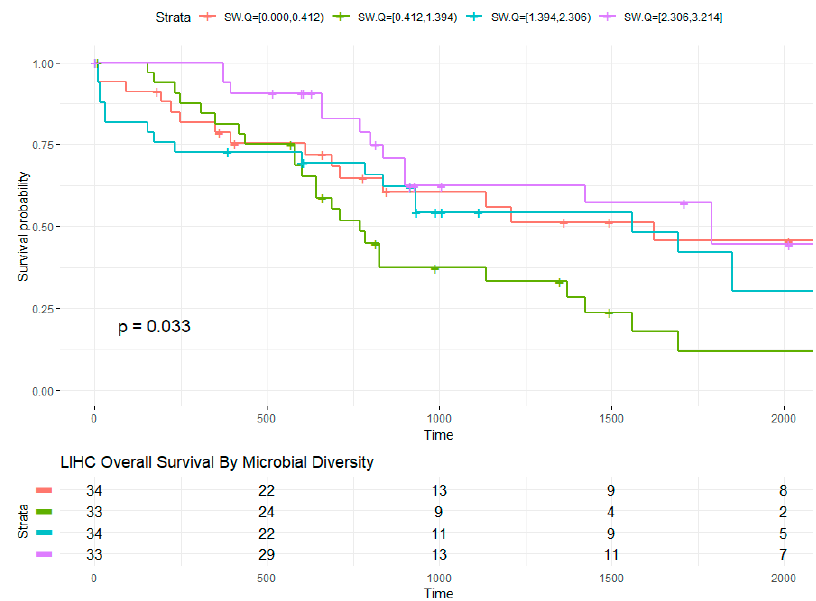
Figure 4. LIHC overall survival by microbial diversity. The survival curve based on Kaplan–Meier estimates (created with survminer) for the relationship between bacterial within-sample diversity and overall survival with global p -value is shown. Strata with risk set size is shown in table. Time in days survived after diagnosis or days to last follow up (censored). Censoring over time are delineated by “+” within the survival lines for each strata.